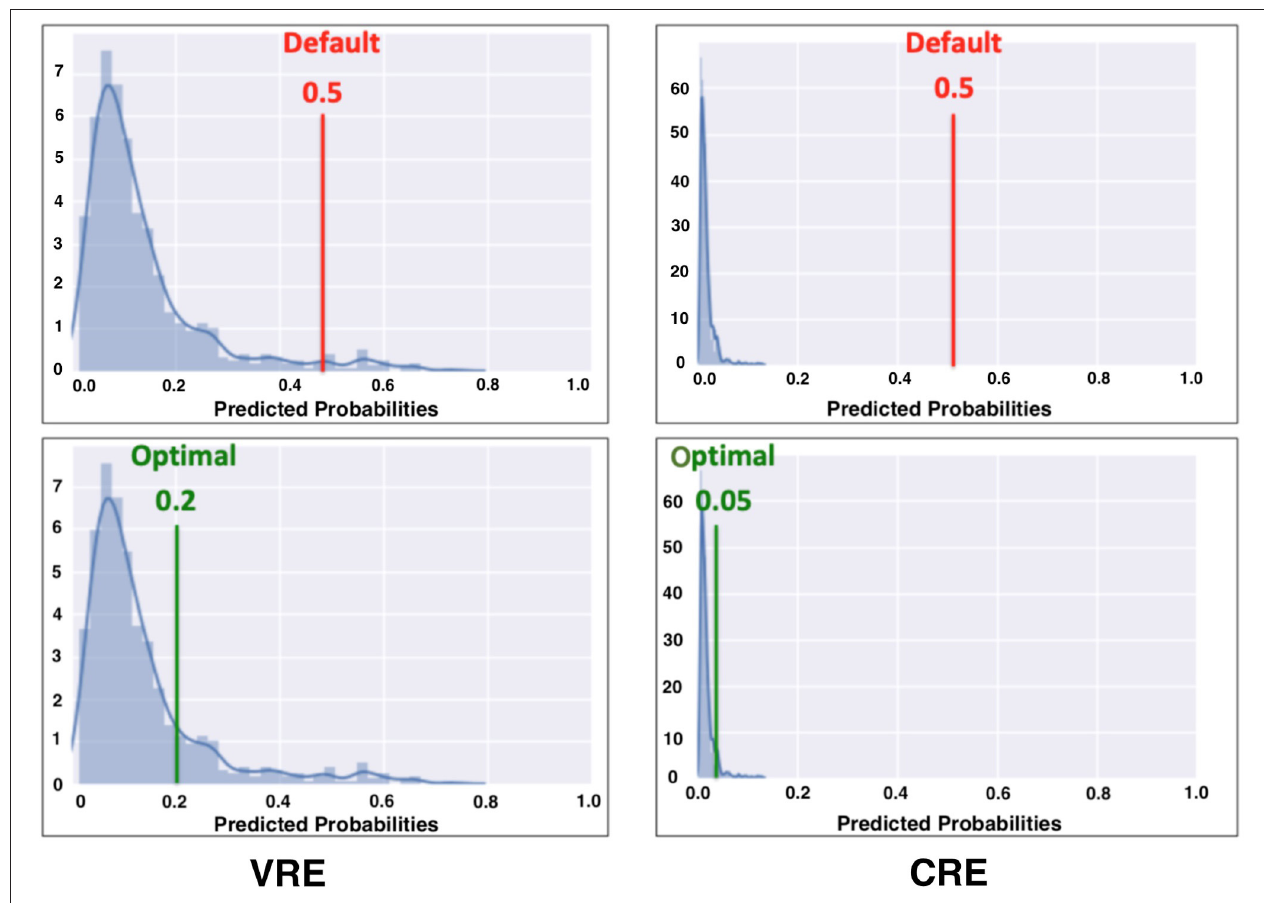
FIGURE 2 | Threshold value for converting predicted probabilities to binary